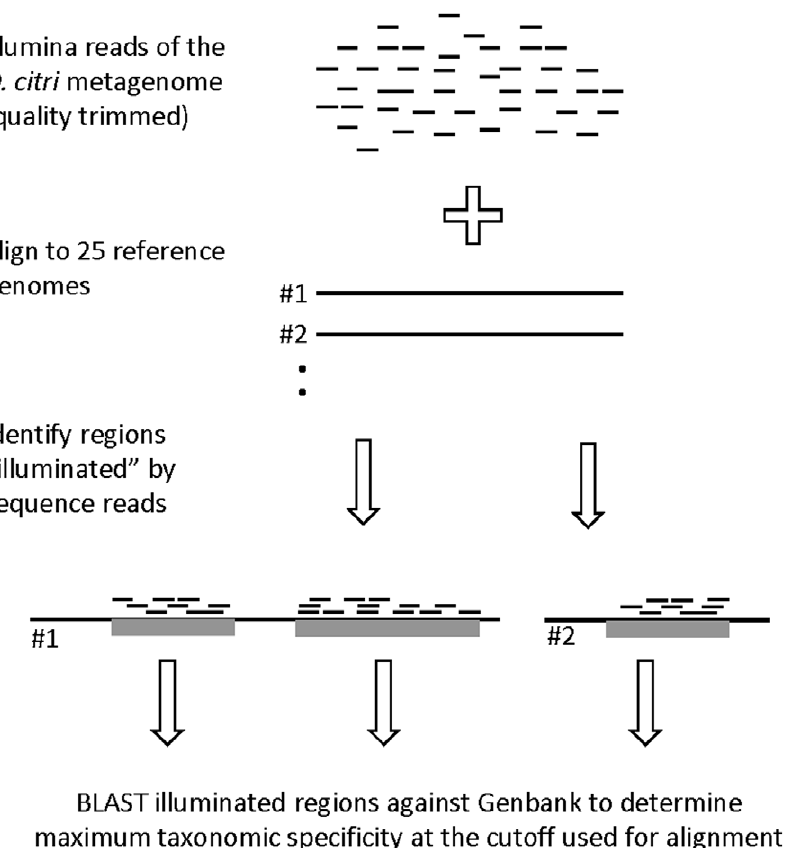
Figure 1. Workflow used to identify regions of reference genomes illuminated by sequence reads from the Diaphorina citri metagenome data set.